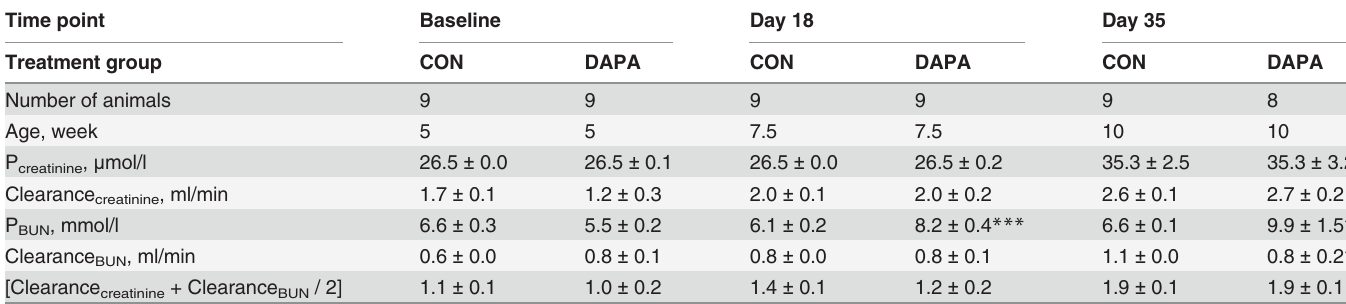
Table 4. Effect of DAPA on renal function in normal SD rats.